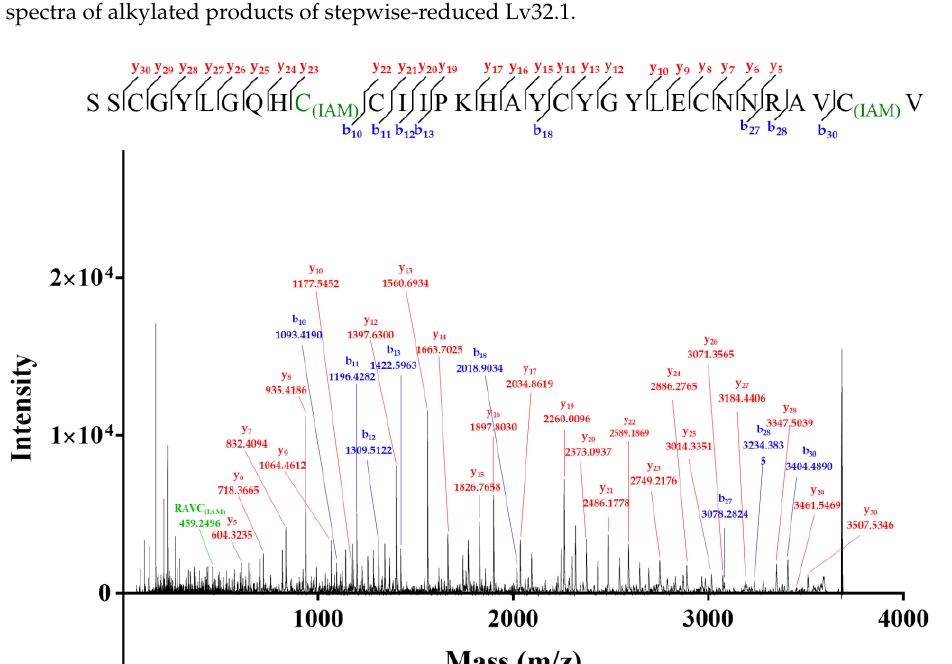
Figure 7. MALDI-TOF-MS/MS spectrum of two-cysteine-alkylated product of Lv32.1. C (IAM) repre- sented the cysteine alkylated by IAM.